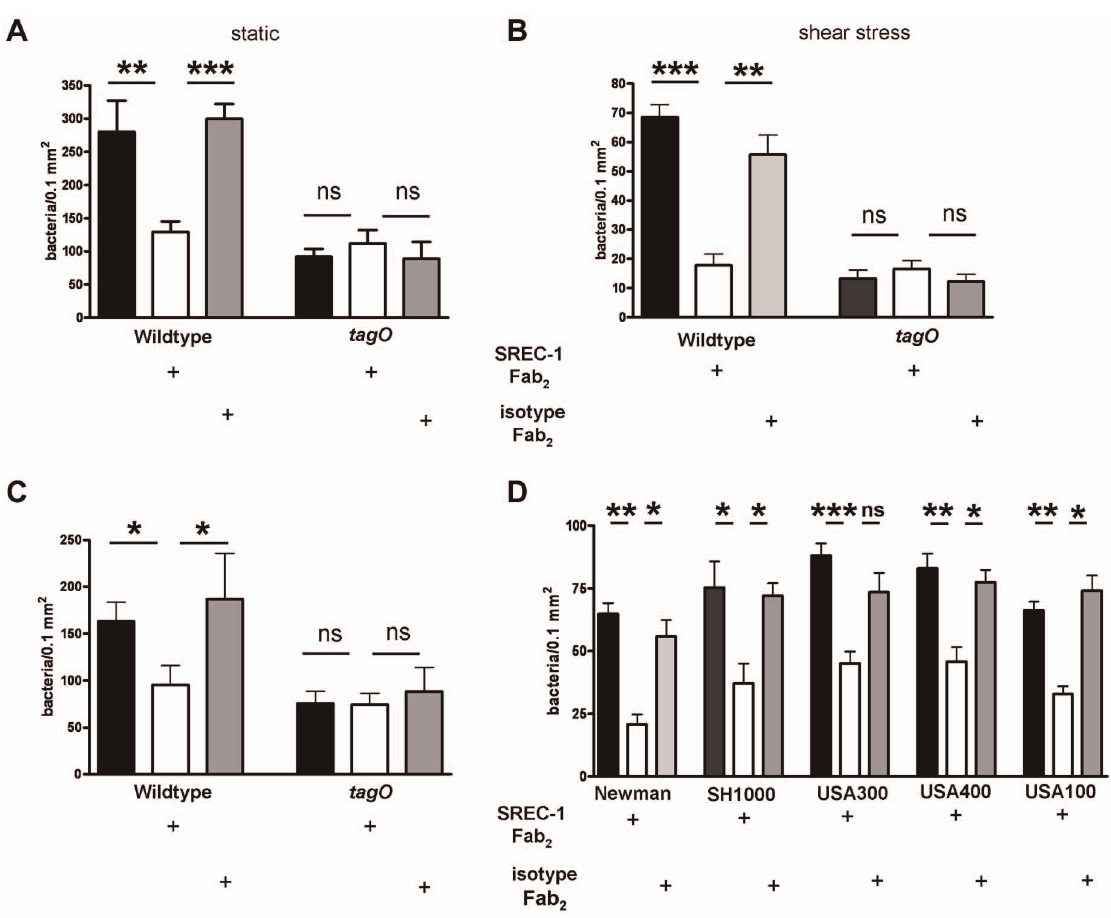
Figure 4. Impact of SREC-I on adhesion of S.aureus to HNECs. Inhibition of SREC-I dependent adhesion to HNECS by Fab 2 - fragments of an anti-human SREC-I antibody in 24 well microtiter plate assays under static conditions (A) and shear stress conditions in ibidi chamber slide assays (B). 10 m g/ml of the anti-SREC-I Fab 2 -fragments and isotype control were used in all assays. Attachment of the S. aureus wild-type (wt), and tagO mutant was evaluated microscopically by counting at least 6 visible fields per well or chamber slide containing HNECs. The data is expressed as the means and SEM of 5 independent experiments under static and flow conditions. Statistical analysis was performed by one-way ANOVA with Bonferroni’s multiple comparison test (A and B). Fab 2 - fragments of an anti-human SREC-I antibody were also used to test the influence of SREC-I on bacterial adhesion under flow condition to CRNECs in ibidi chamber slide assays (C). 10 m g/ml of the SREC-I Fab 2 -fragments and isotype control were used in all assays. Attachment of the S. aureus wild-type (wt), and tagO mutant was evaluated microscopically by counting at least 6 visible fields per chamber slide containing CRNECs. The data represent mean and SEM of 5 independent experiments. Statistical analysis was performed by one-way ANOVA with Bonferroni’s multiple comparison test. (C) We also tested the influence of SREC-I on the adhesion of other S. aureus strain backgrounds (D). Fab 2 - fragments of an anti-human SREC-I antibody were used under flow conditions in ibidi chamber slide assays with HNECS. 10 m g/ml of the SREC-I Fab 2 - fragments and isotype control were used in all assays. Attachment of the S. aureus Newman (wt), and SH1000 mutant was evaluated microscopically by counting at least 6 visible fields per chamber slide containing CRNECs. The data represent mean and SEM of 4 independent experiments. Statistical analysis was performed by one-way ANOVA with Bonferroni’s multiple comparison test. (D) Significant differences between groups are indicated by one ( P , 0.05), two ( P , 0.01), or three ( P , 0.001) asterisks ( * ).